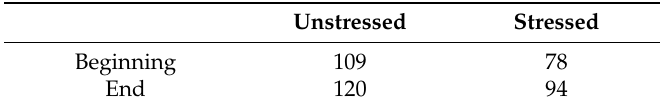
Table A14. Token counts for vowel formant measurements used to visualize vowel space and calculate vowel space area for Informant E in Section 4.2.5.